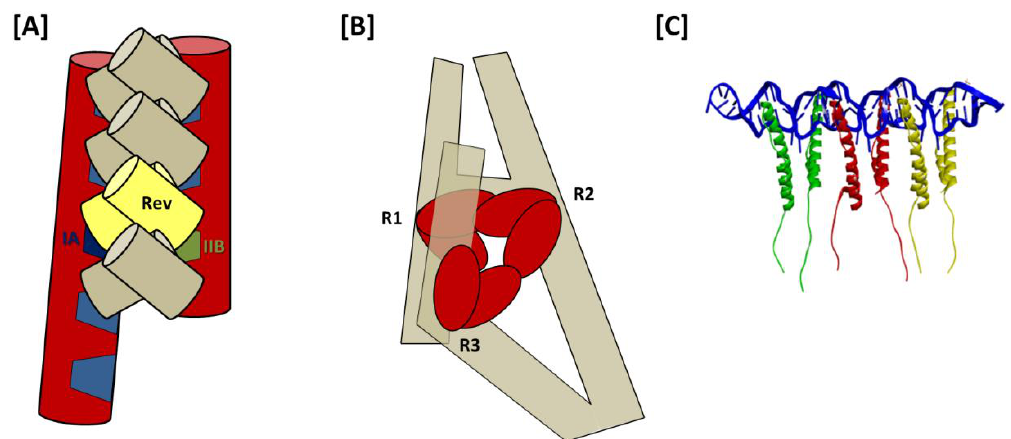
Figure 6. Models for assembly of HIV-1 Rev on the RRE: ( A ) “Bridging” model. The first